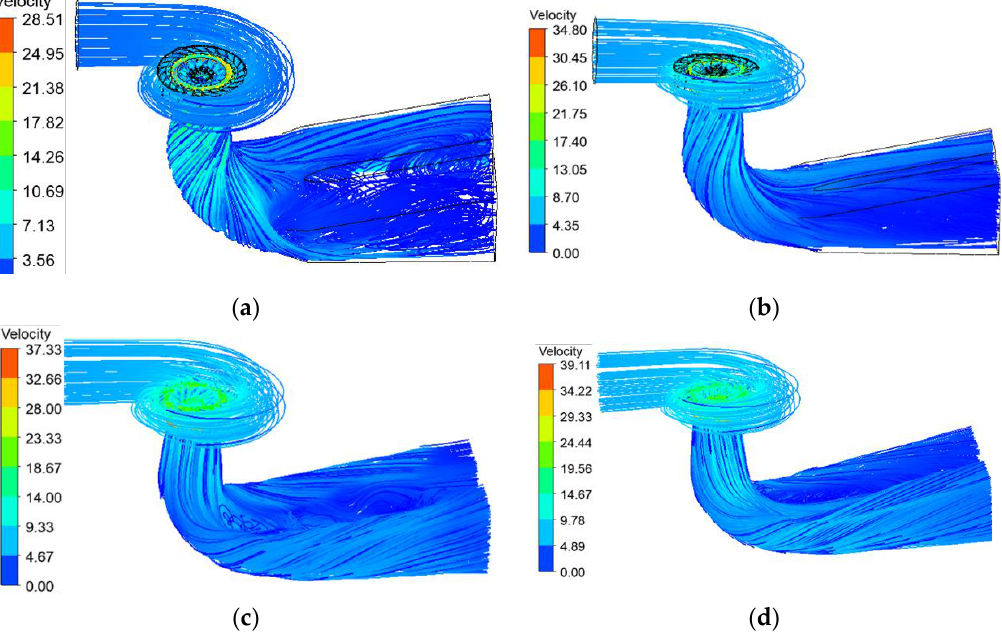
Figure 6. Overall flow pattern in the channel under different guide vane opening. ( a ) 10 ◦ , ( b ) 20 ◦